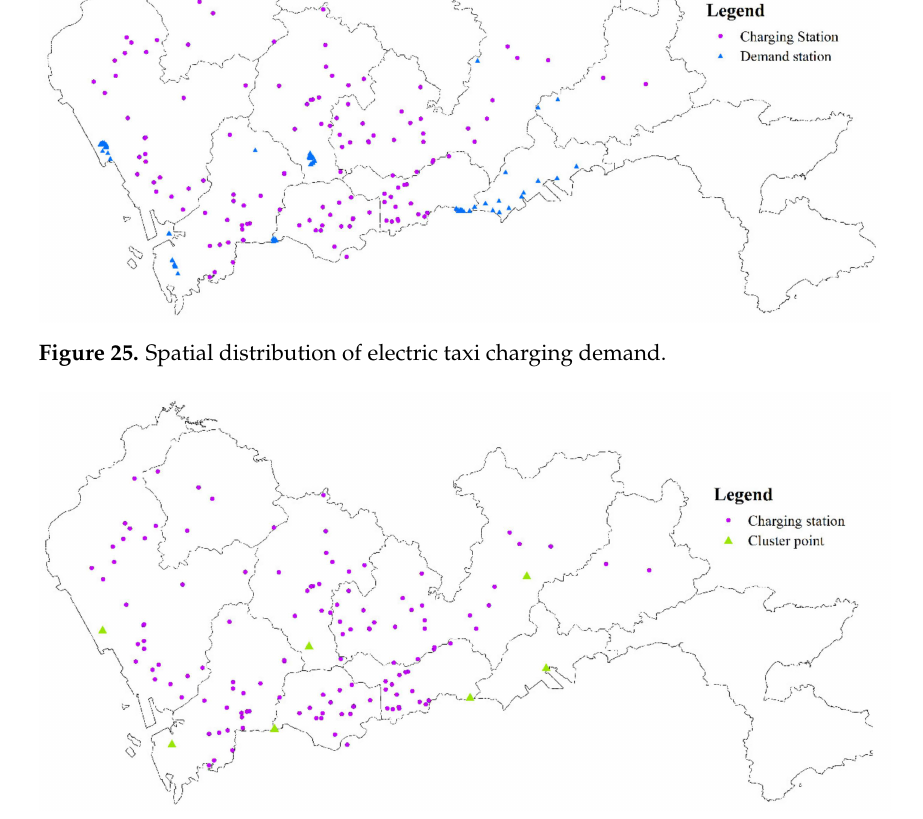
Figure 26. Clustering